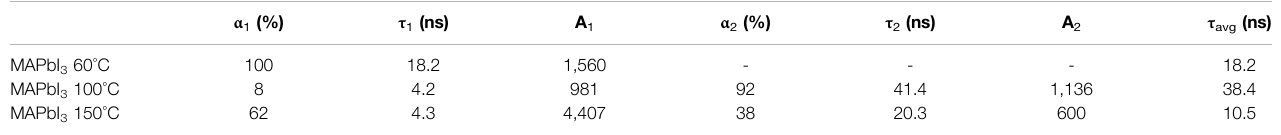
TABLE 3 | Summary of the PL characteristics obtained after reconvolution from IRF for MAPbI3 depending on the crystallization temperature.